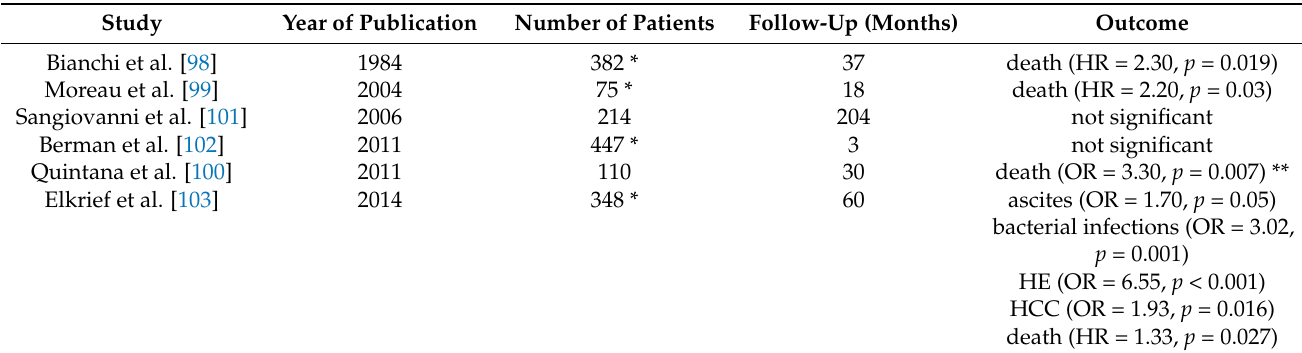
Table 1. Longitudinal studies conducted on cirrhotic patients evaluating the impact of diabetes on liver-related events and mortality. * Decompensated cirrhosis; ** not significant according to multivariate